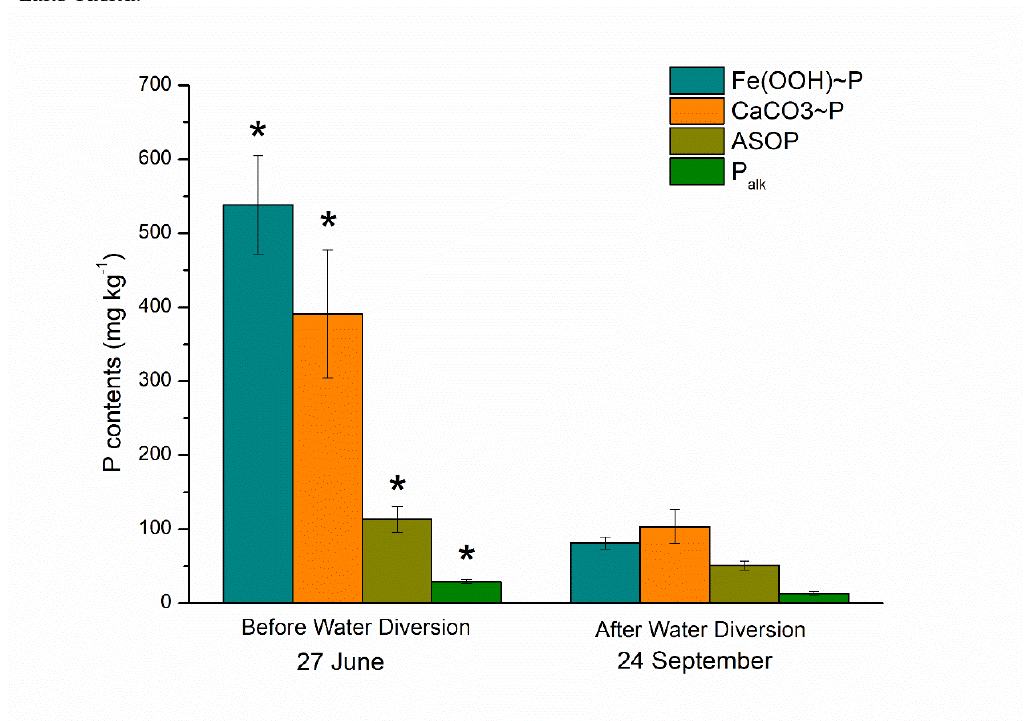
Figure 5. Sediment P fractionations before and after water diversion in Lake Yuehu. Asterisks (*) indicate significant di ff erence ( P <